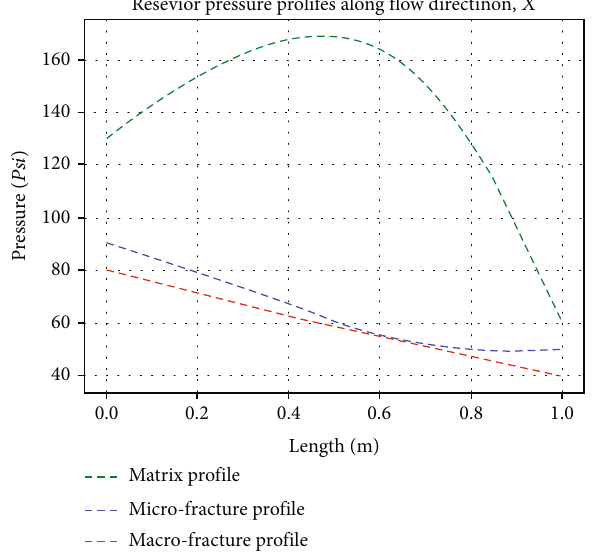
Figure 8: Pressure pro fi le showing the direction of fl ow of matrix, microfracture, and macrofracture